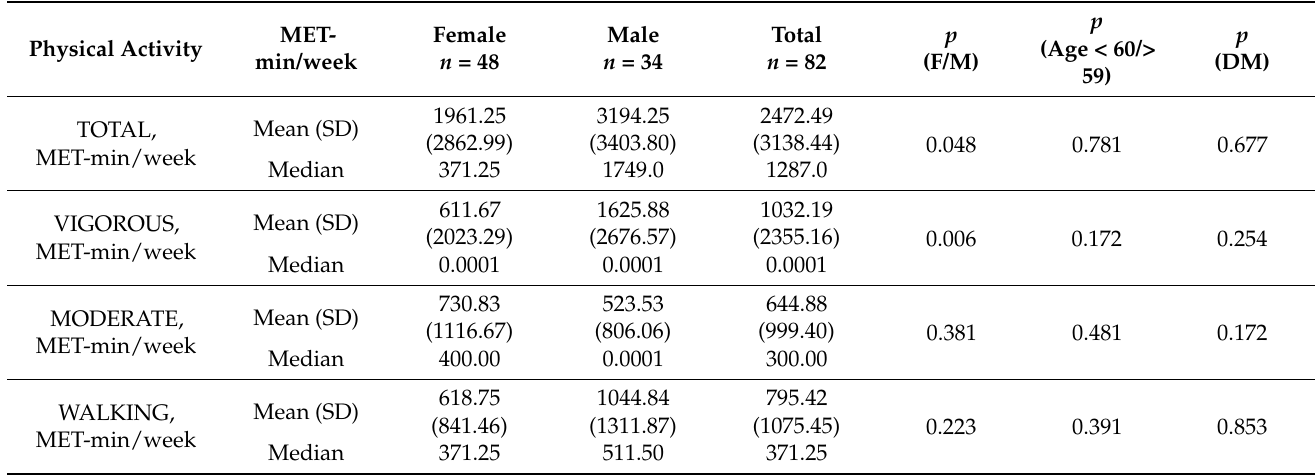
Table 2. Various levels of PA of the participants by gender, age, and diagnosed DM (with the Mann–Whitney U test).